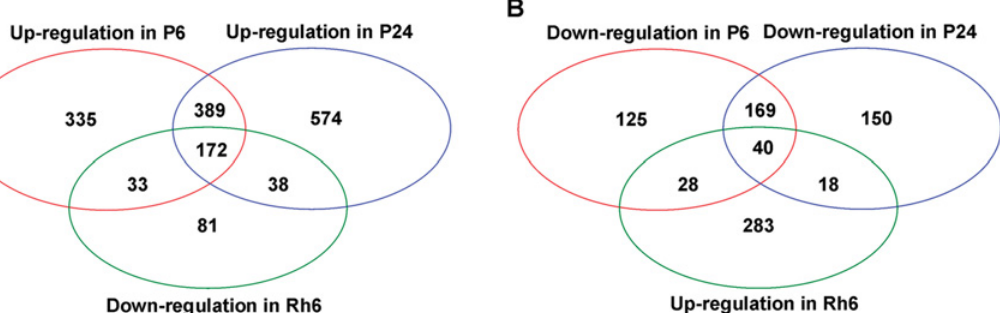
Fig 8. Venn diagrams showing the number of the common and specific DEGs in P-6h, P-24h and Rh-6h. The analysis were based either on genes up regulated in P-6h and P-24h (compared to P-0h) and down regulated in Rh-6h (compared to P-24h) (A), or on genes down regulated in P-6h and P-24h (compared to P-0h) and up regulated in Rh-6h (compared to P-24h)